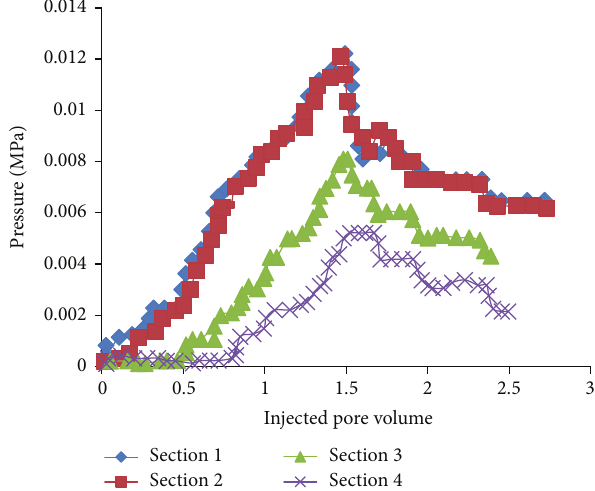
Figure 14: The plot of the injection pressure (diameter: 0.02– 0.06 mm, concentration: 5000 mg/L).